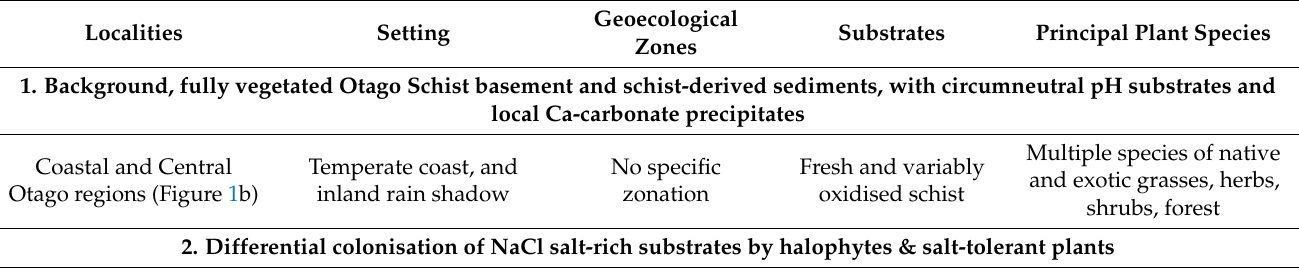
Table 1. Summary of key features, substrate chemistry, and plant species distributions at the mine sites and surrounding areas described in this study. EC = electrical